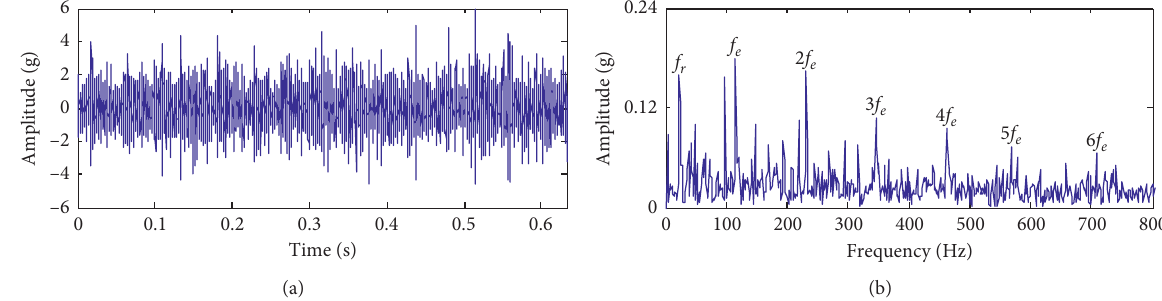
Figure 13: Analysis results of experimental signal by CYCBD with optimal parameters: (a) the waveform of deconvolution signal; (b) the envelope spectrum of deconvolution